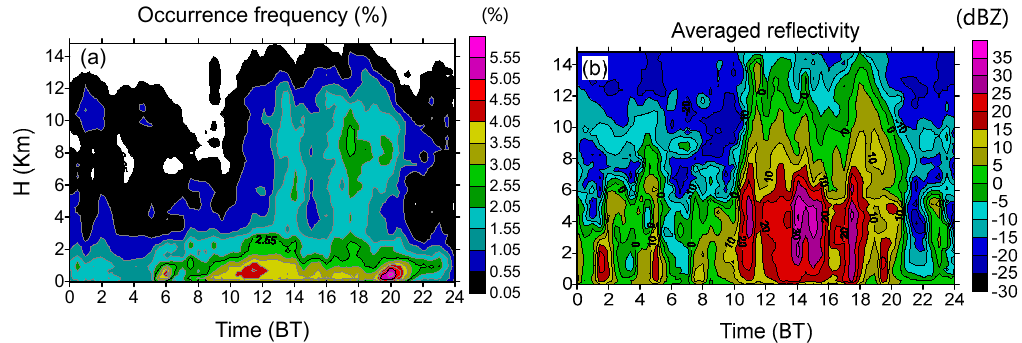
Figure 10. Diurnal variations in ( a ) the occurrence frequency of the valid merged reflectivity and ( b ) averaged reflectivity at various altitudes in South China during July 2016.